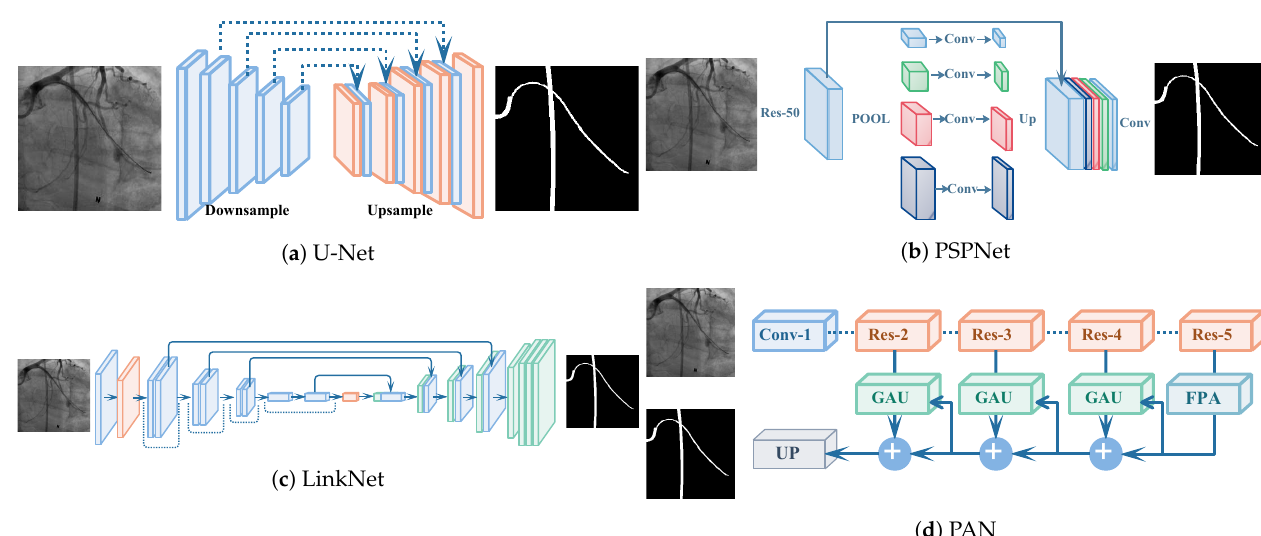
Figure 2. Overview of the segmentation networks employed to train and evaluate the augmentation techniques